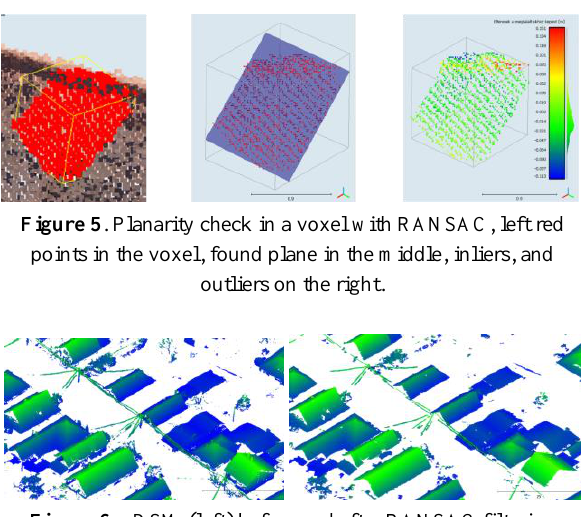
Figure 6. nDSM (left) before and after RANSAC filtering